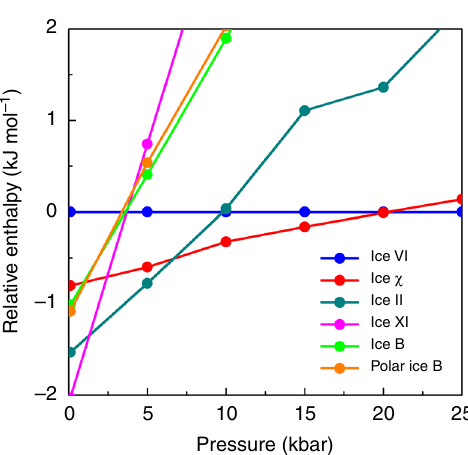
Fig. 4 Relative enthalpy per water molecule. Relative enthalpy per water molecule (based on vdw-DF2 calculations without including ZPE correction) versus P for ice χ , ice II, ice XI, ice B, and polar ice B, where ice VI is taken as the reference in the calculation